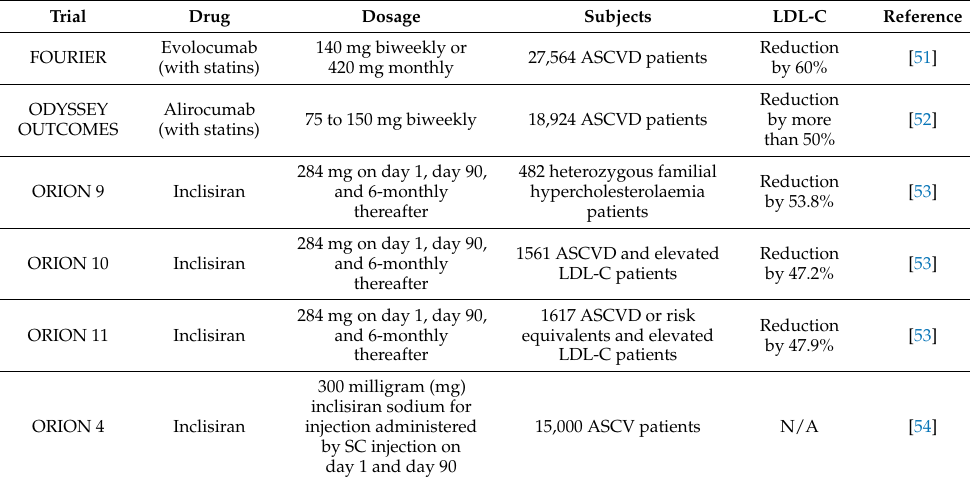
Table 1. Trials on the efficacy and safety of PCSK9